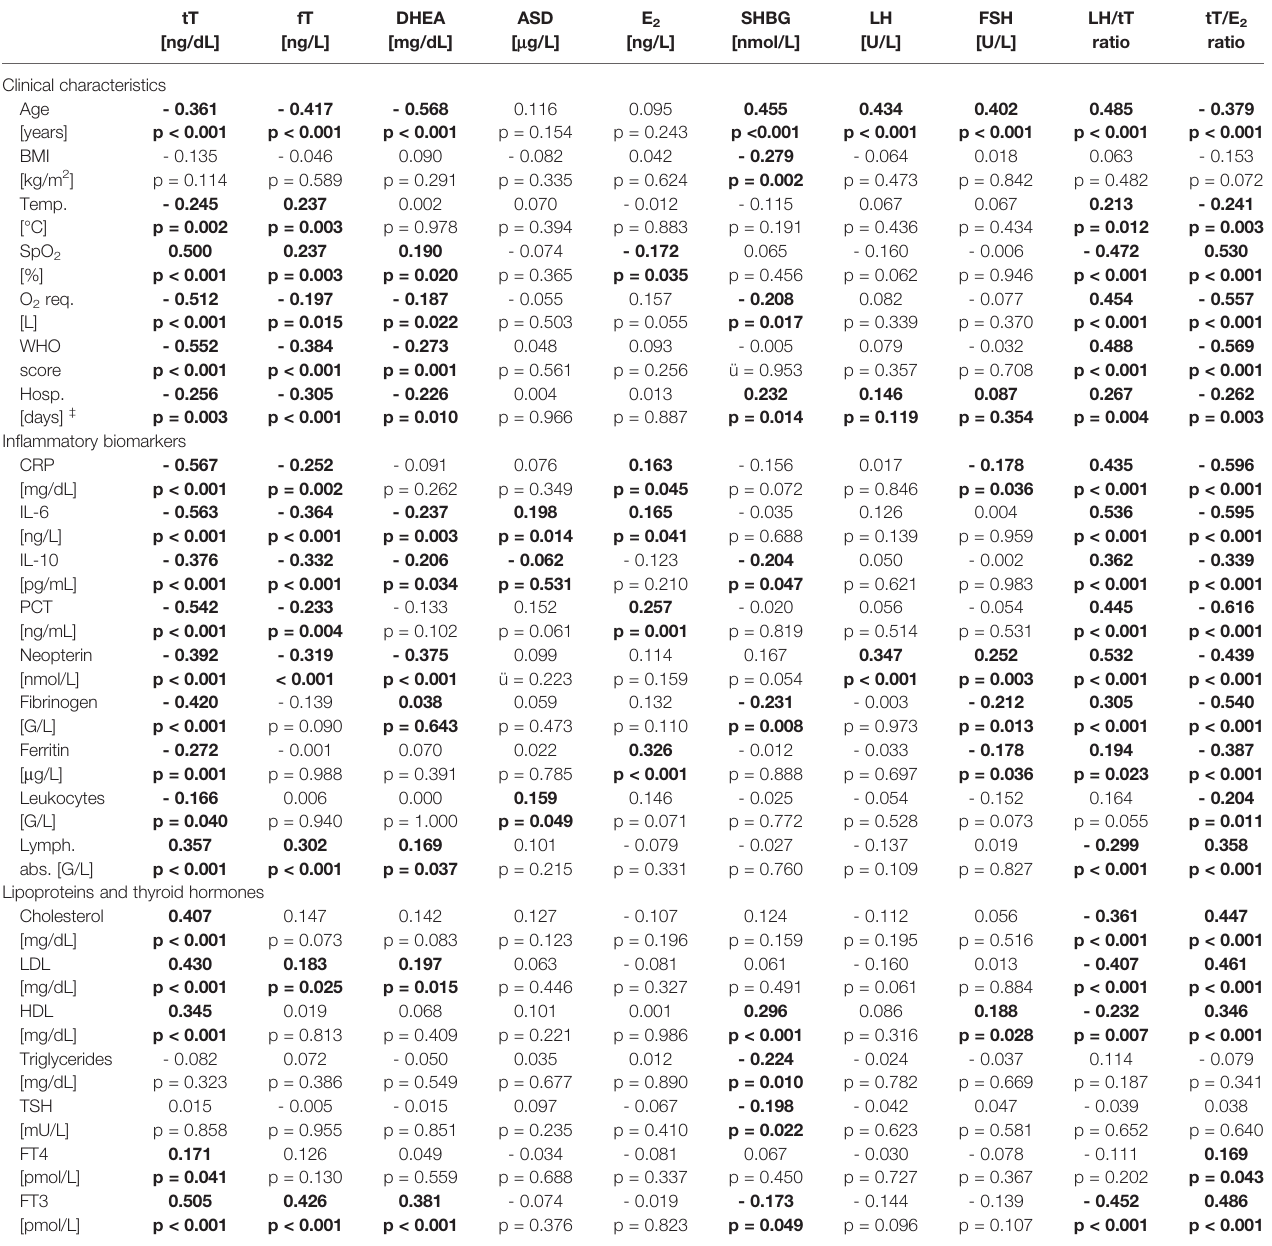
TABLE 3 | Correlations of sex hormones with clinical characteristics and laboratory parameters in